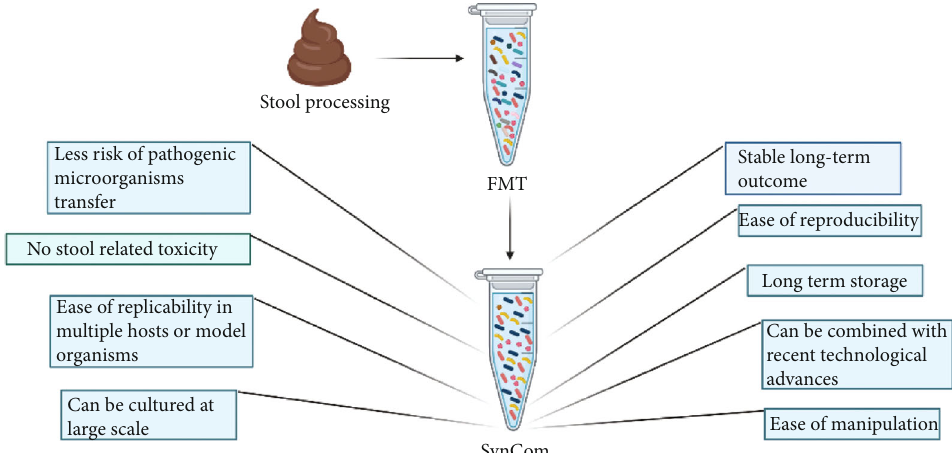
Figure 3: Advantages of SynCom-based transplants over conventional FMT. Various advantages of the SynCom-based FMT include relatively more safety, stable results, relatively less stool toxicity, and ease of